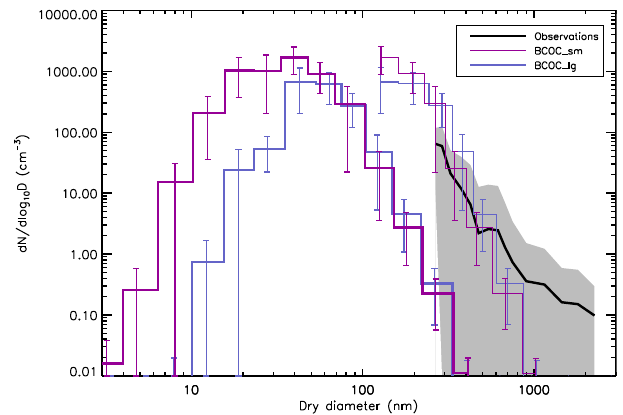
Fig. 9. Vertical profile of measured non-volatile particle number concentration ( D p > 14nm) from the DLR Falcon 20 aircraft (black) compared with modelled number concentration of BC+OC particles ( D p > 14nm) (colour). The average over all measurement flights performed during the LONGREX campaign (May 2008) is shown (sectioned into 600m altitude bins). The error bars and shading rep- resent the standard deviation of the model and observations respec- tively. Model experiments, BCOC sm and BCOC lg, are described in Table 2. In the BCOC vsm experiment, the peak diameter of the BC+OC emission size distribution in BCOC sm is reduced by a factor of ∼ 1 . 2.